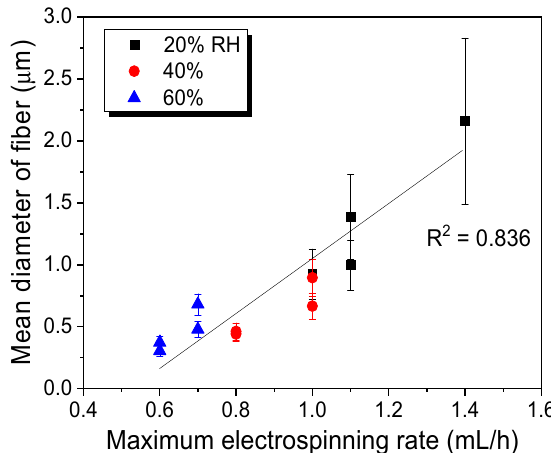
Figure 4. Relationship between the maximum electrospinning rate of silk solution and the fiber diameter of electrospun silk web ( n = 30). The error bars represent the standard deviation. 3.2. Effects of Relative Humidity on the Molecular Conformation of Electrospun Silk Web The molecular conformation of silk has been extensively examined because it affects